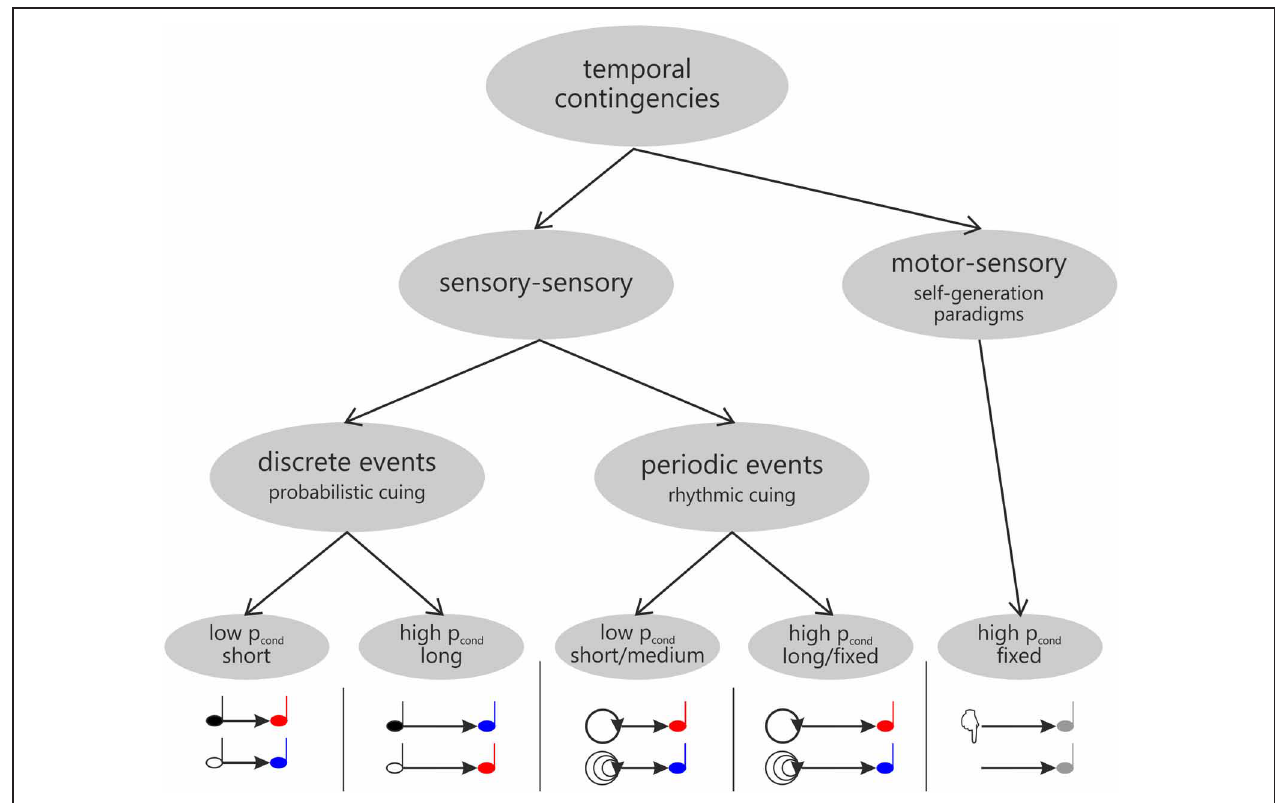
FIGURE 3 | Overview of different types of contingencies underlying temporal expectations as manipulated in probabilistic (left) and rhythmic cuing (middle) and self-generation paradigms (right), respectively.